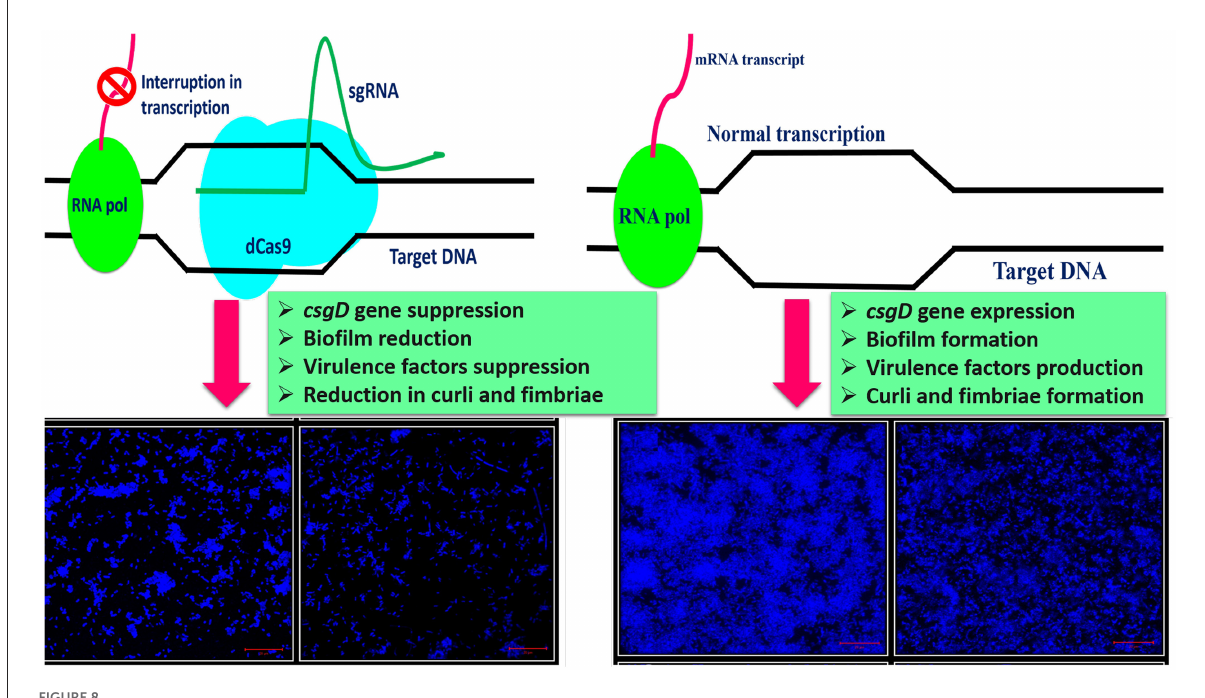
FIGURE8 A comprehensive overview of the